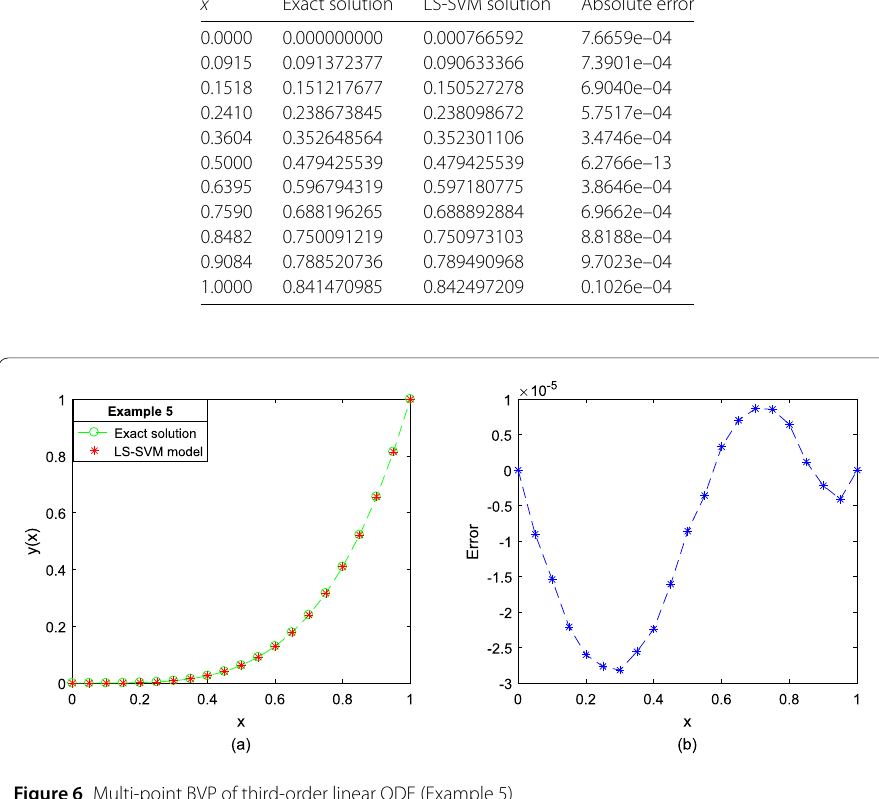
Figure 6 Multi-point BVP of third-order linear ODE (Example 5)